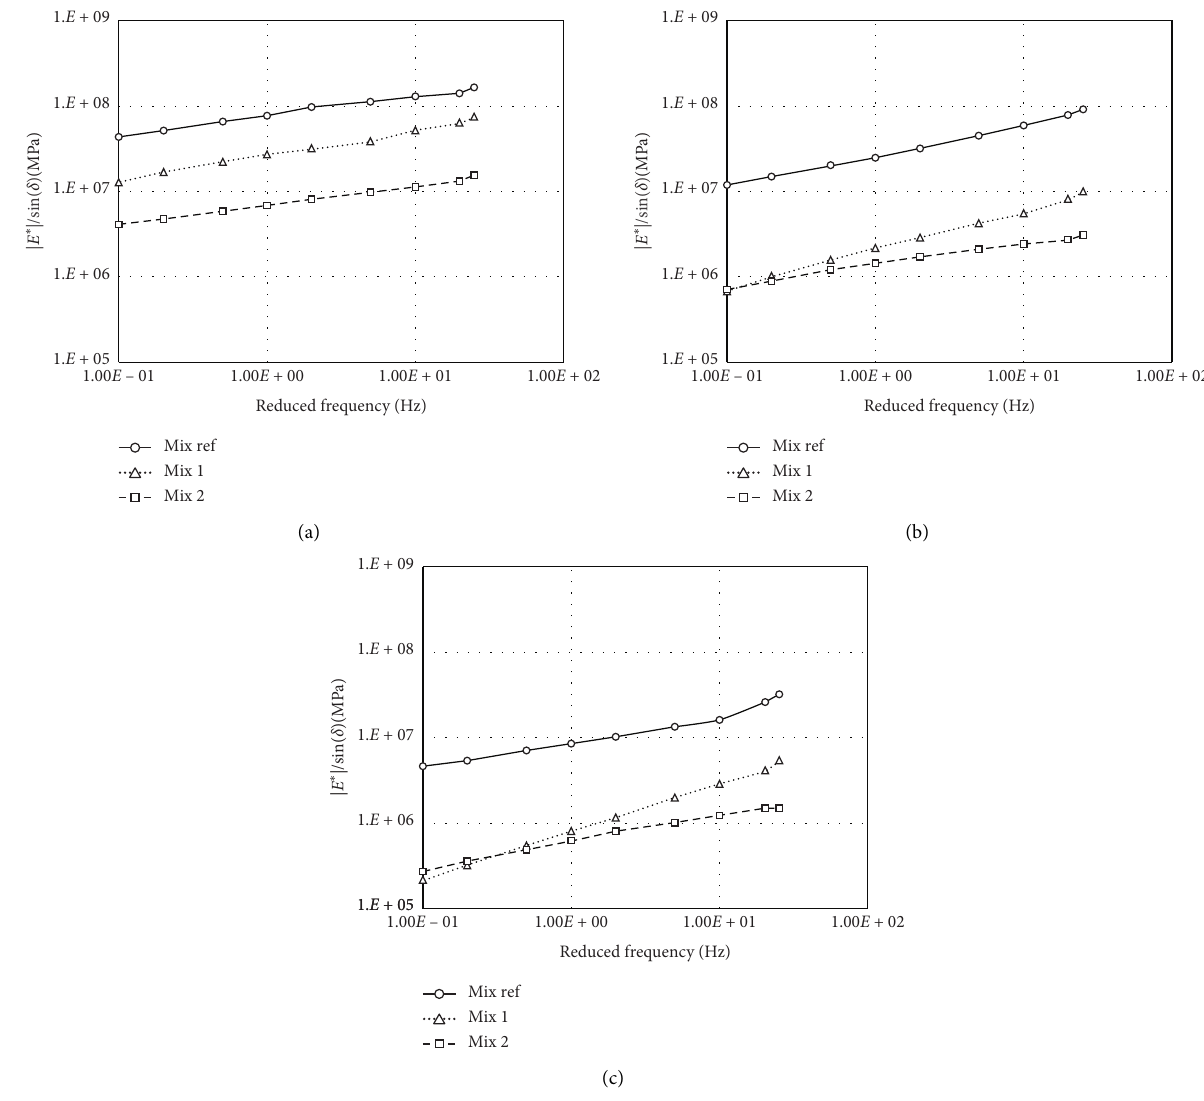
Figure 10: Rutting parameters at (a) 5 ° C, (b) 20 ° C, and (c) 31 °